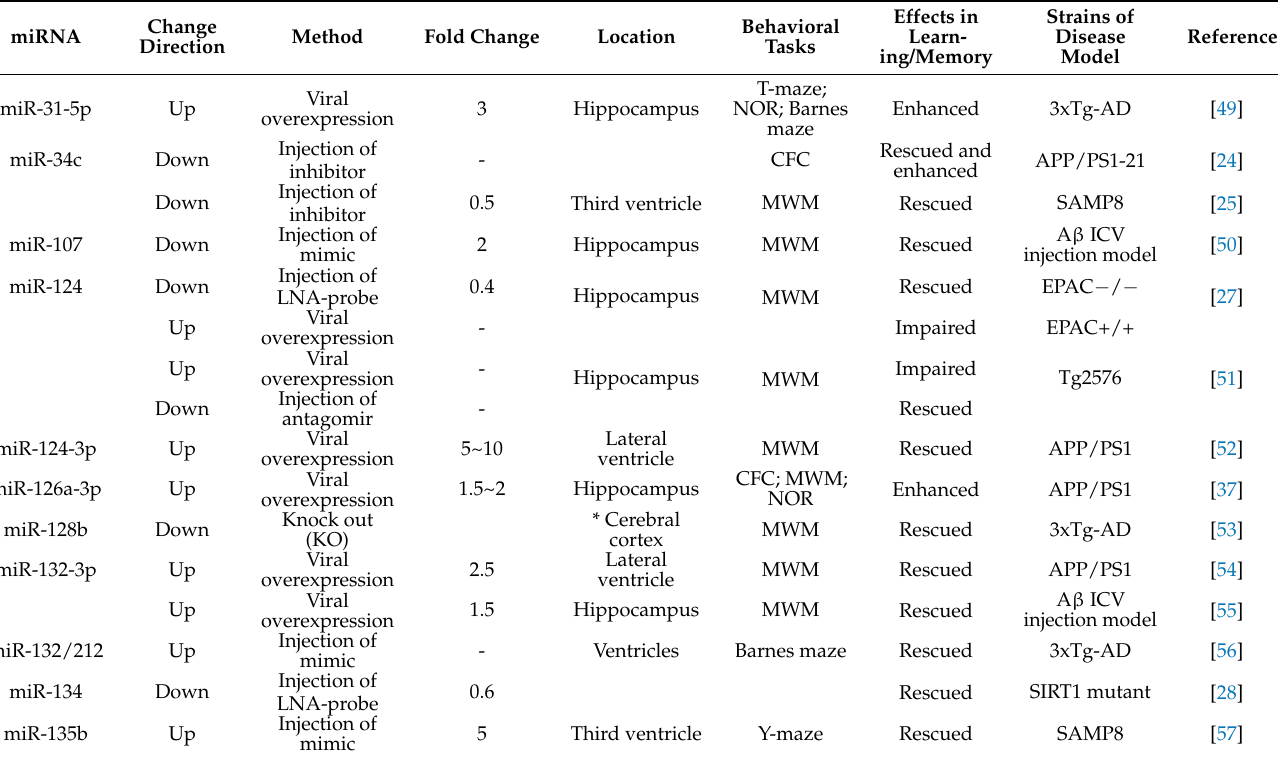
Table 2. Manipulation of miRNA levels in regulating learning and memory in transgenic, mutant, or stressed